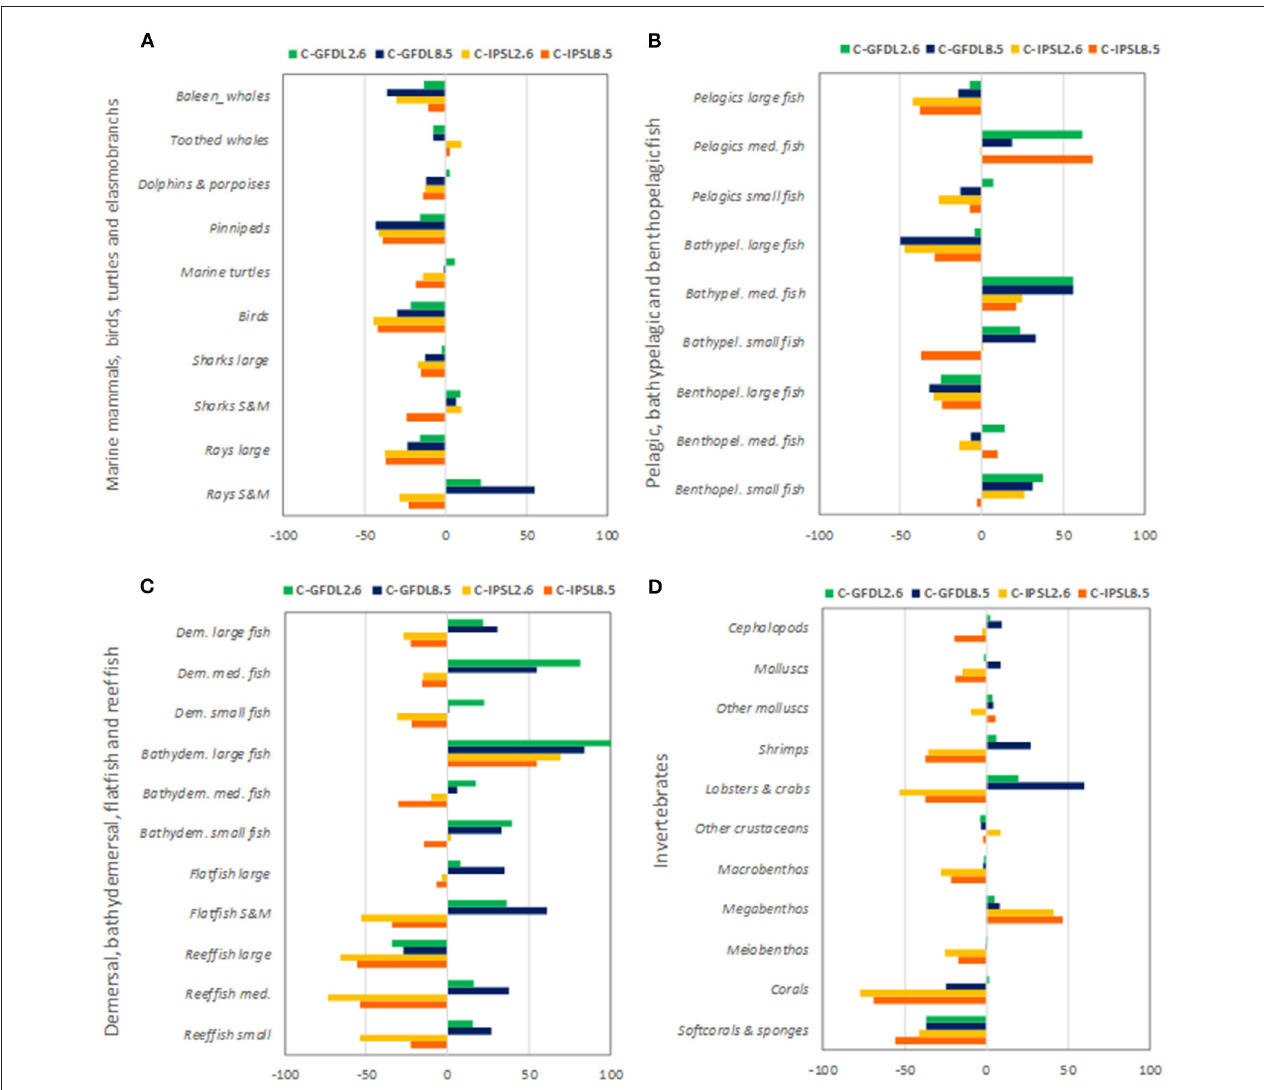
FIGURE 9 | Experiment 2 (Climate impacts, Table 1 )—Relative temporal biomass change (%) between 1970 and 2100 by species groupings: (A) Marine mammals, seabirds, marine turtles, and elasmobranchs, (B) Pelagic, bathypelagic, and benthopelagic fish, (C) Demersal, bathydemersal, flatfish, and reef fish, and (D)